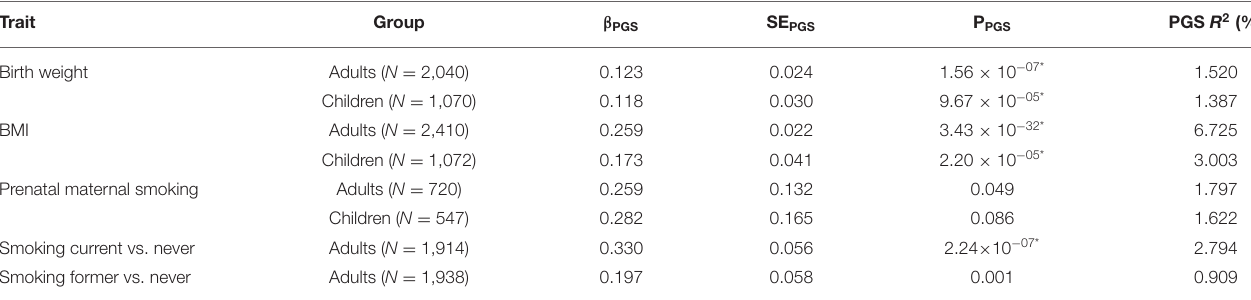
TABLE 4 | Results of the polygenic score prediction of birth weight, BMI, prenatal maternal smoking, and current and former smoking. Trait Birth weight